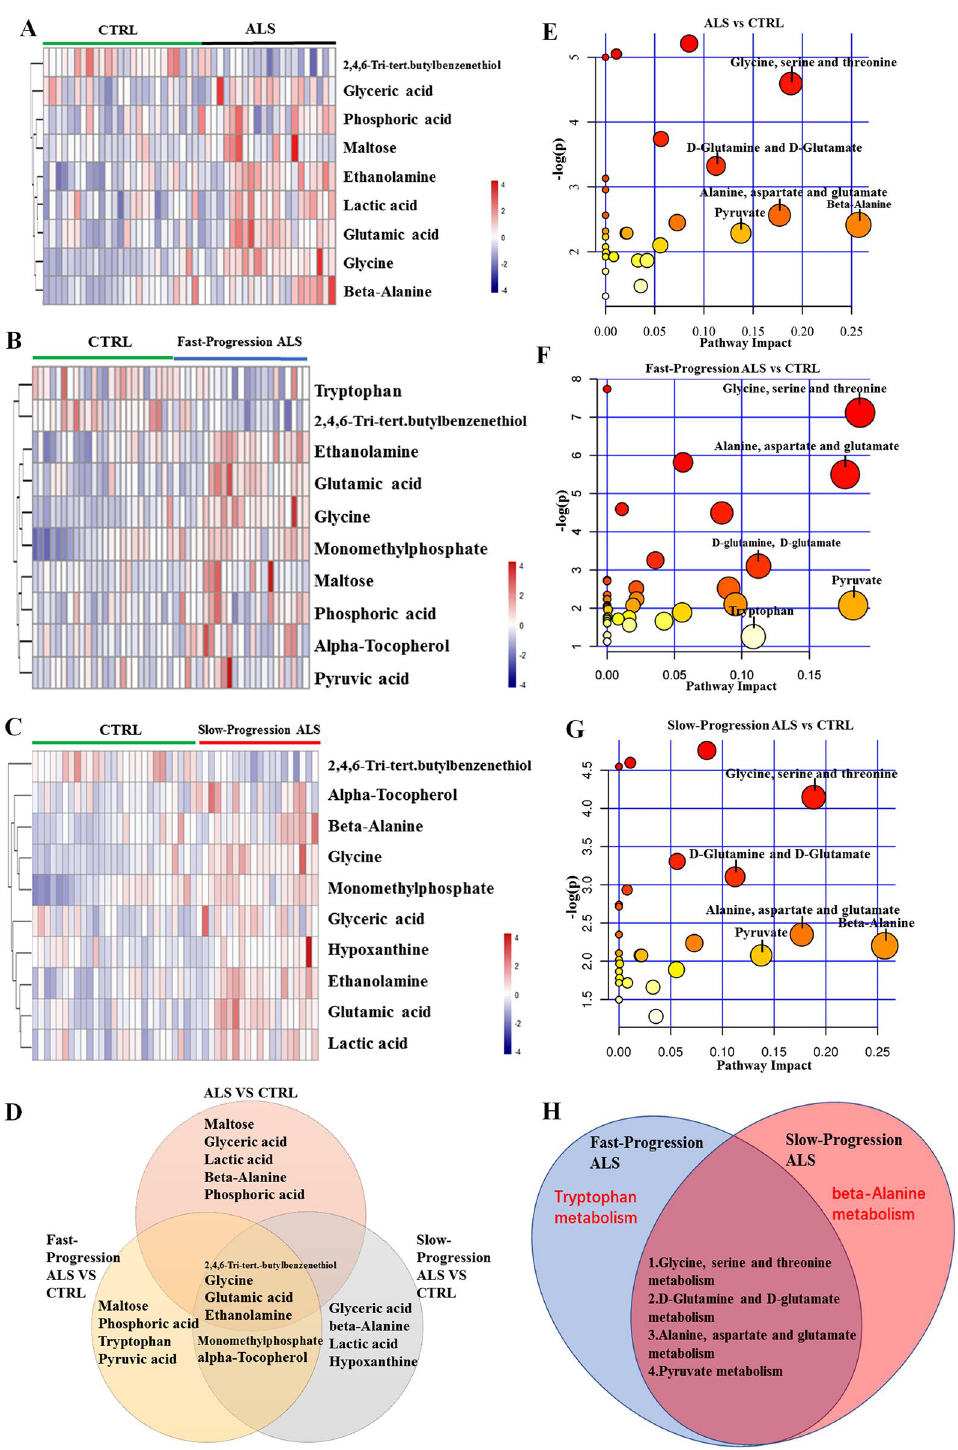
Figure 2. Heatmap visualization of differential serum metabolites and metabolic pathways. ( A – C ) Heatmap visualization of ( A ) ALS versus CTRL, ( B ) Fast-progression ALS versus CTRL, and ( C ) Slow-progression ALS versus CTRL. ( D ) Differential metabolites in the three comparison groups. ( E – G ) The altered metabolic pathways in the ( E ) ALS, ( F ) fast-progression ALS, and ( G ) slow-progression ALS groups compared with the CTRL group. ( H ) Differential metabolic pathways in the fast- and slow-progression ALS